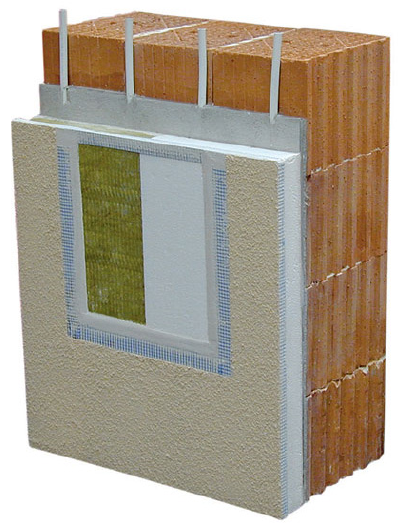
Figure 4. Application of TB on a brick wall [5].